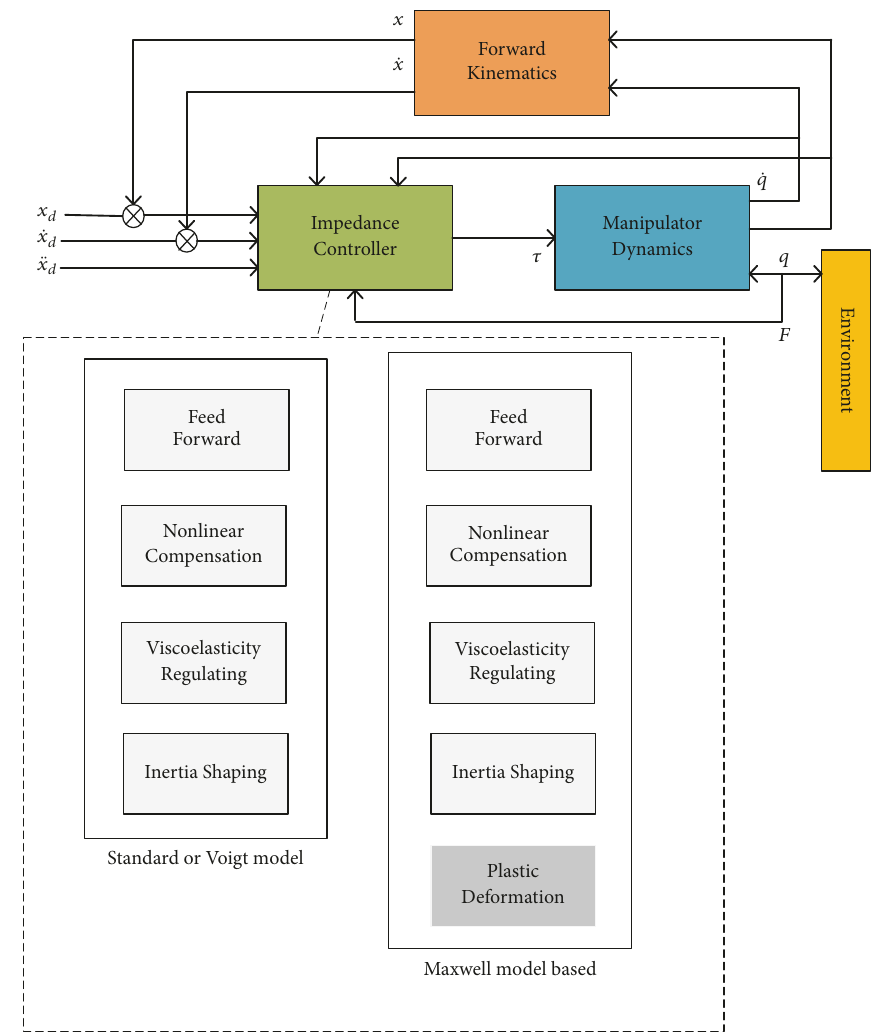
Figure 3: Cartesian impedance control architecture of our method and standard impedance